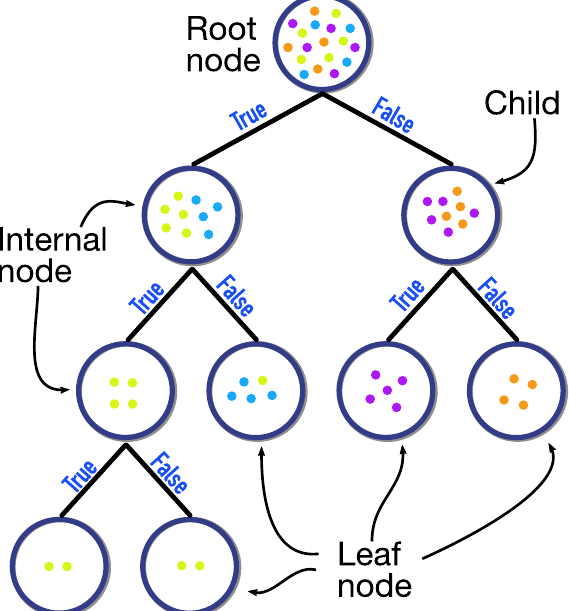
Figure 1. Decision tree